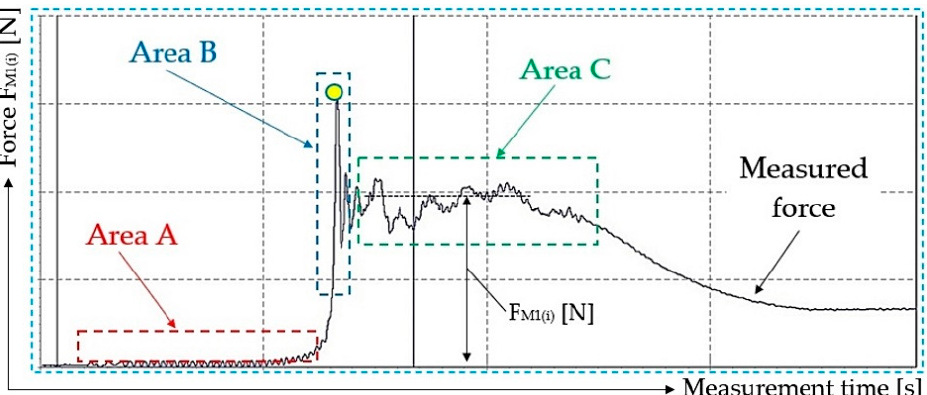
Figure 11. Tensile force recording, expressing the movement resistance of the conveyor belt. A part of the time curve for the measured force recording shown in Figure 12 is divided using dashed lines into three areas.